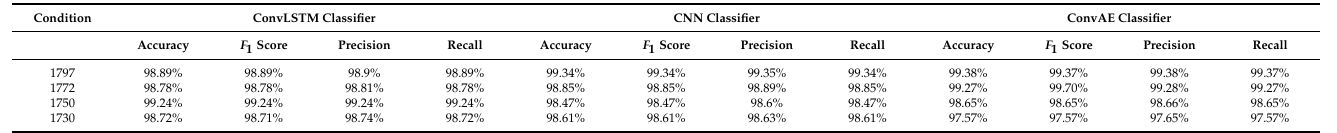
Table 3. Classifier accuracy, F 1 score, precision, and recall for test data in different conditions while the training condition is 1797